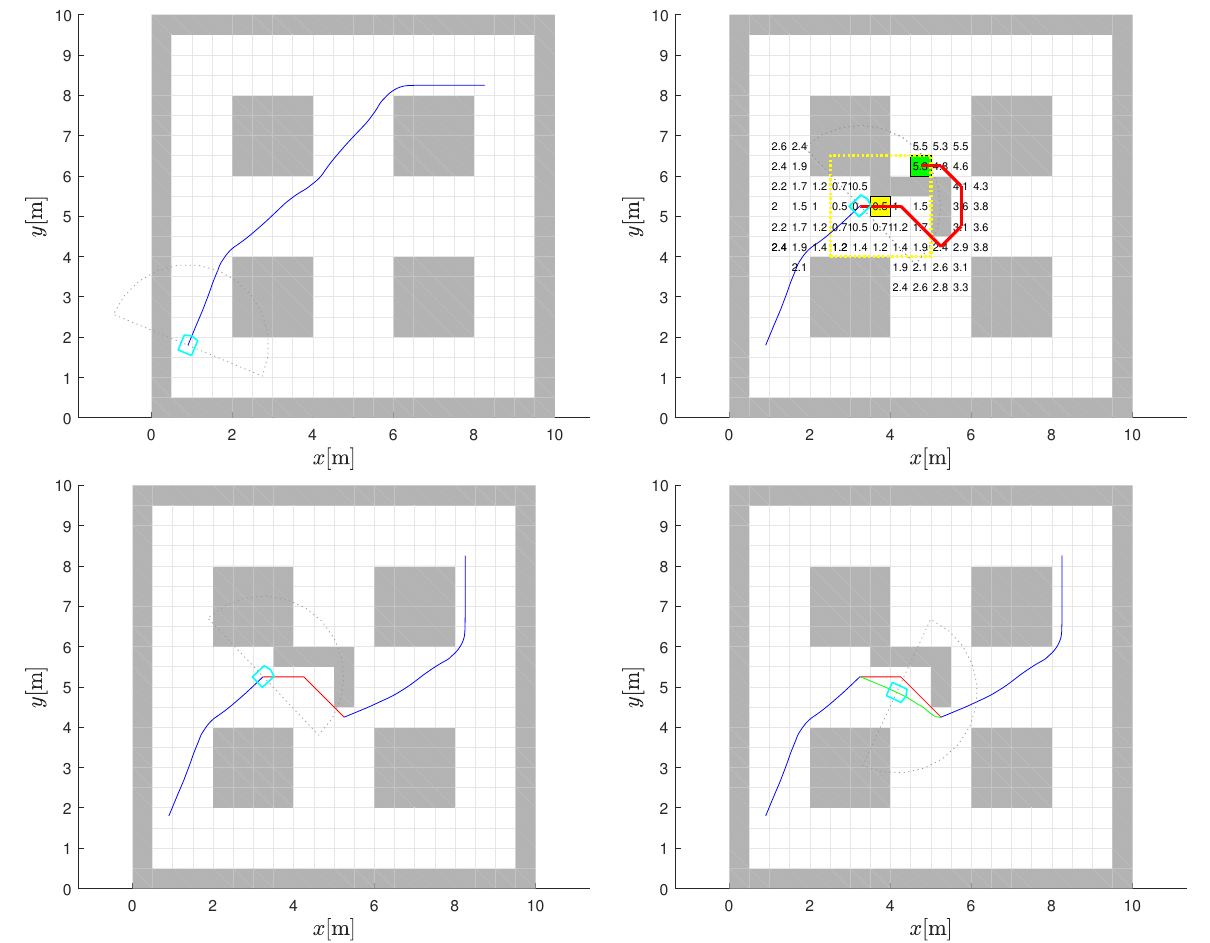
Figure 8. Strategy to negotiate dynamic obstacles. Original planned path based on the static environ- ment map shown is shown with blue line ( top-left ). New obstacle blocking path initiates A ∗ bypass (red line) calculation from stuck cell (highlighted in yellow) to the temporary intermediate goal cell (highlighted in green) ( top-right ). The leave point and final overall path is shown with A ∗ bypass ( bottom-left ) and in by smoothed bypass (green line) using BiLI interpolation ( bottom-right